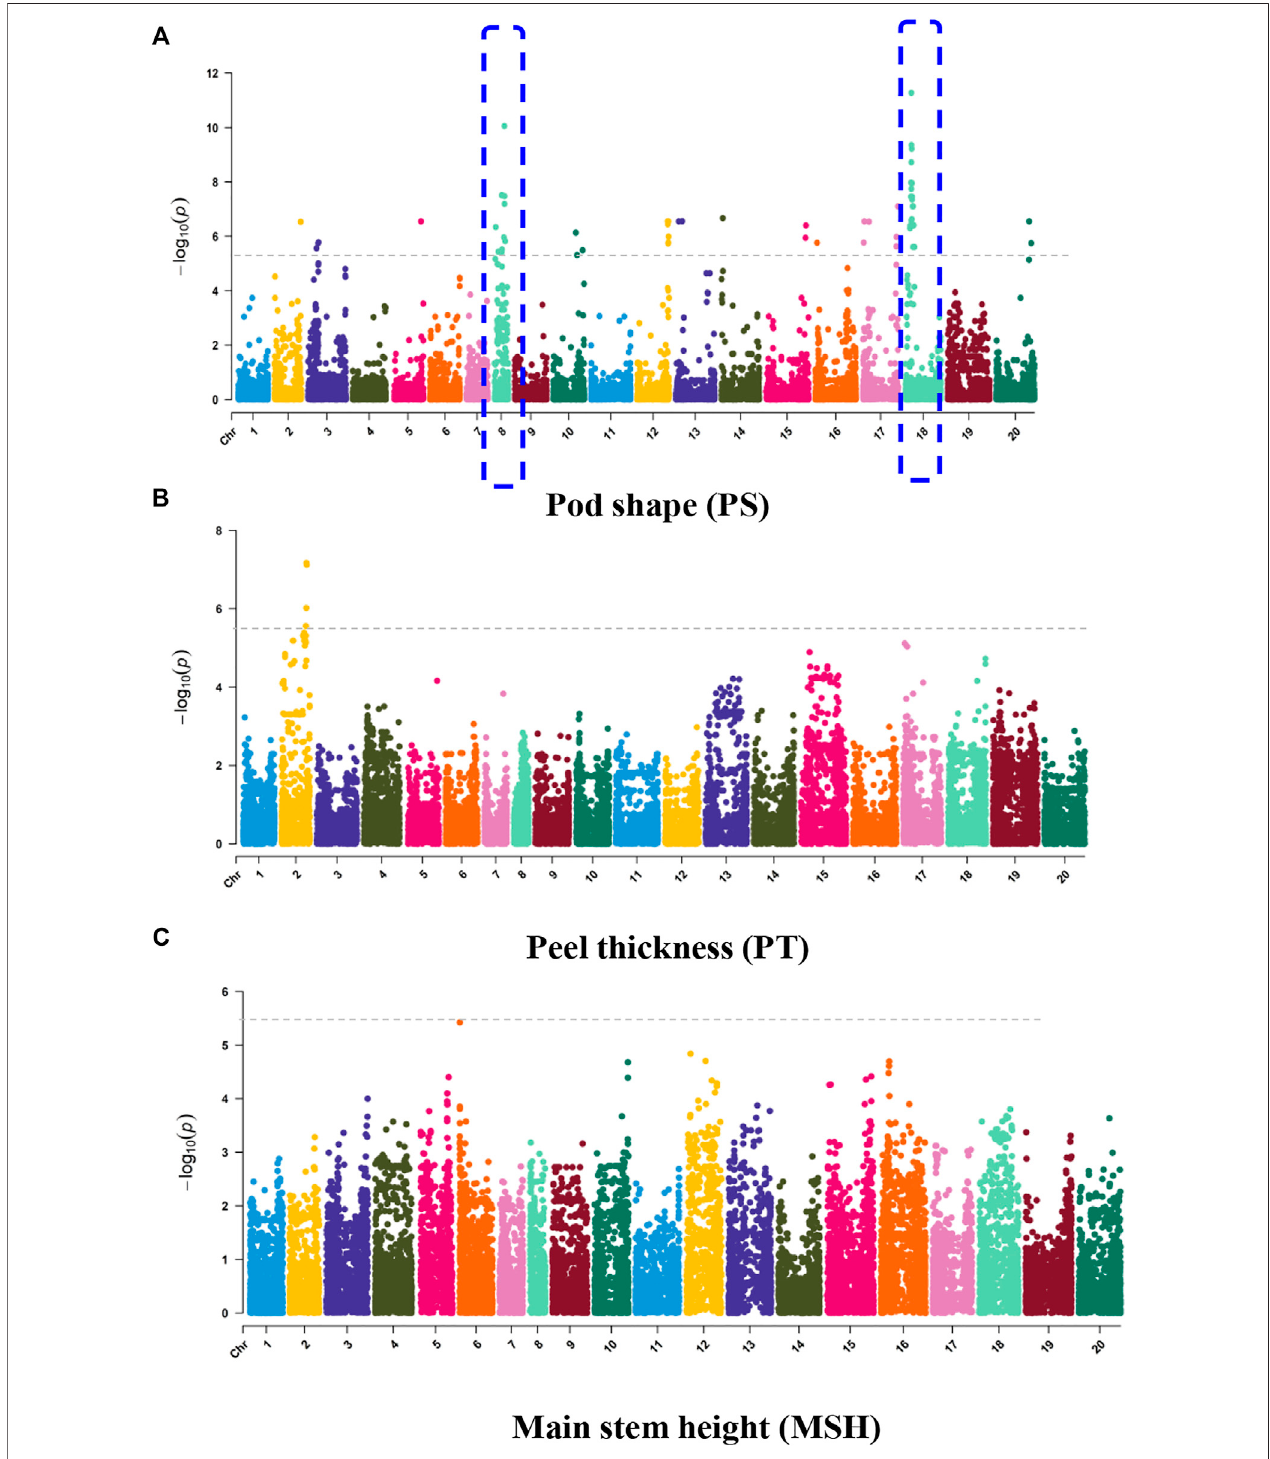
FIGURE 6 | GWAS signals for (A) pod shape, (B) peel thickness, and (C) main stem height, related to the appearance of peanut.